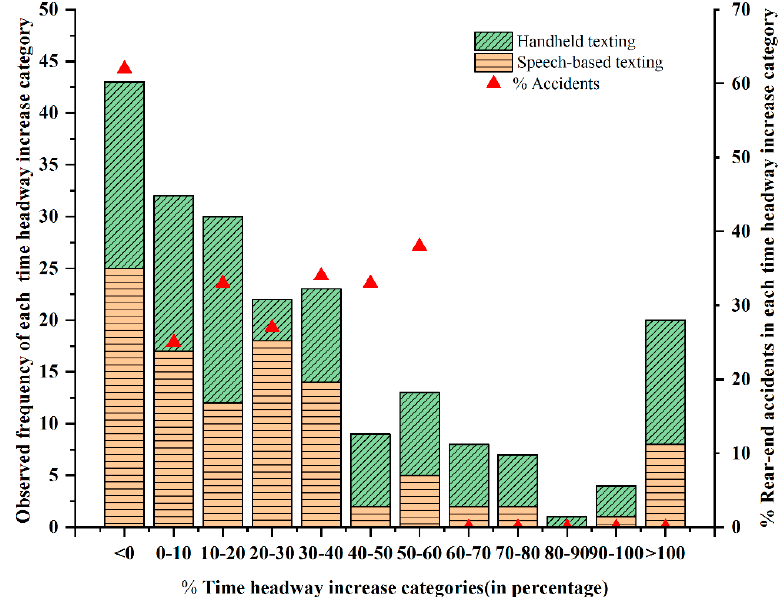
Figure 4. Time headway increase patterns of all drivers during distracted driving conditions.